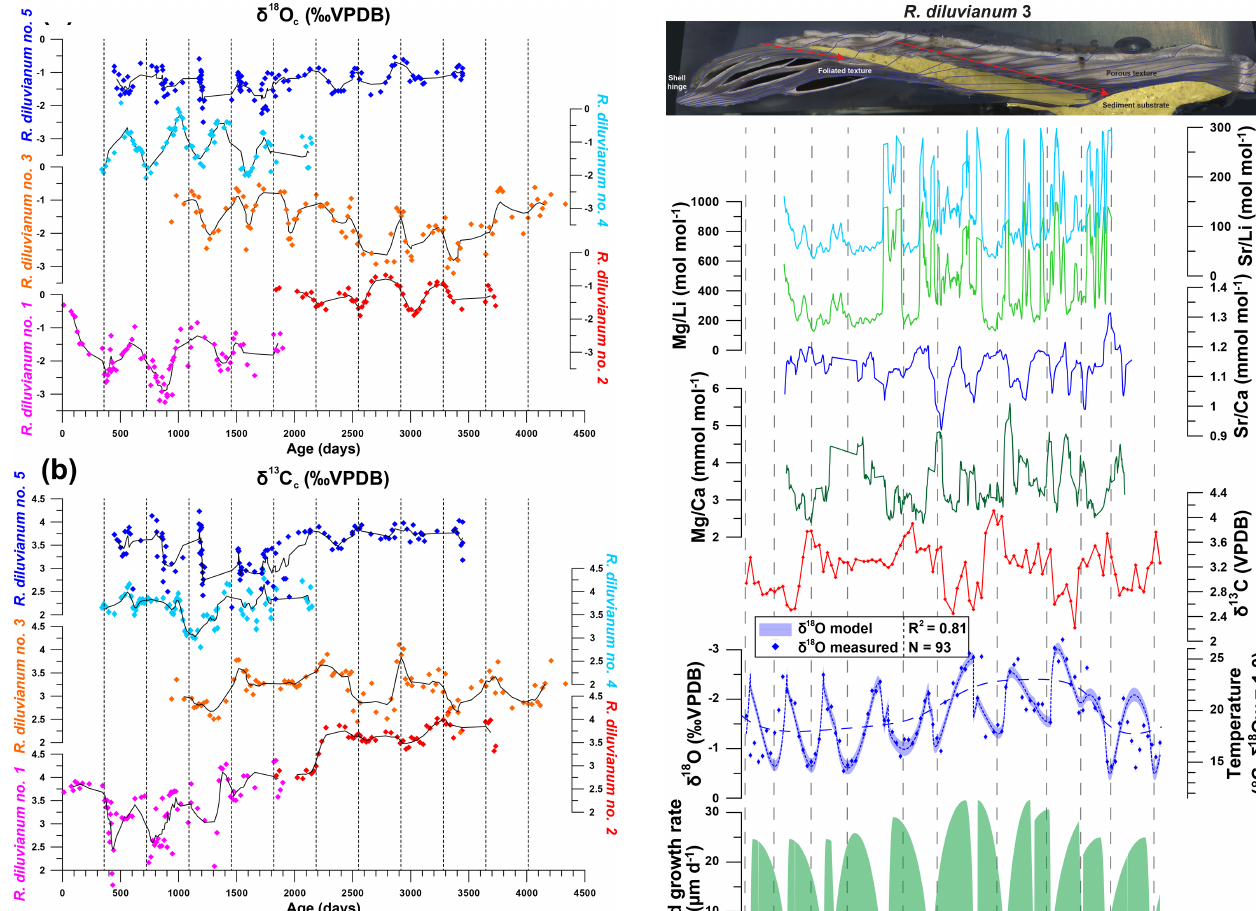
Figure 6. Overview of stable oxygen (a) and carbon (b) profiles from all five shells in which stable isotope profiles were measured and plotted against ontogenetic ages. Black lines indicate five-point running averages through the time series. Vertical dashed lines sep- arate years of growth. All vertical axes of δ 18 O and δ 13 C have the same scale. Color coding is the same as in Fig. 7.